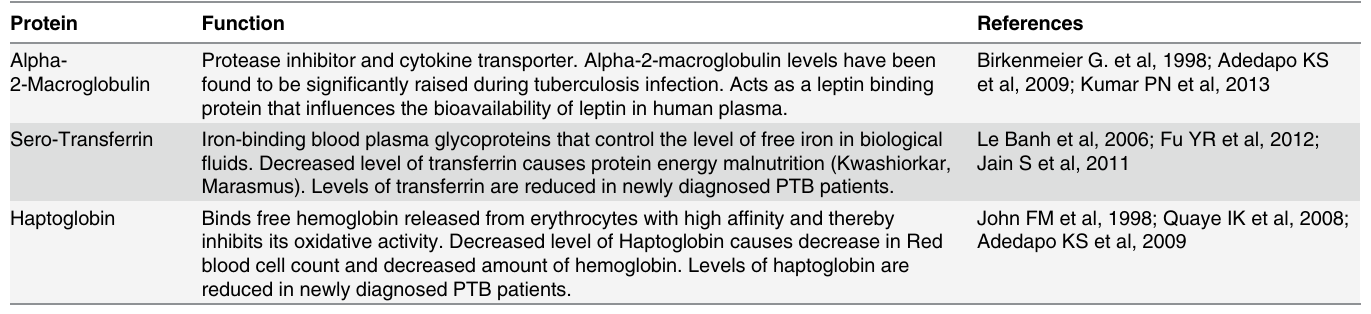
Table 5. Protein functions in tuberculosis and malnutrition.